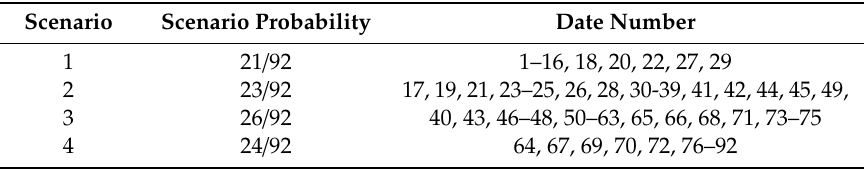
Table 2. The results of multi-scenario division.